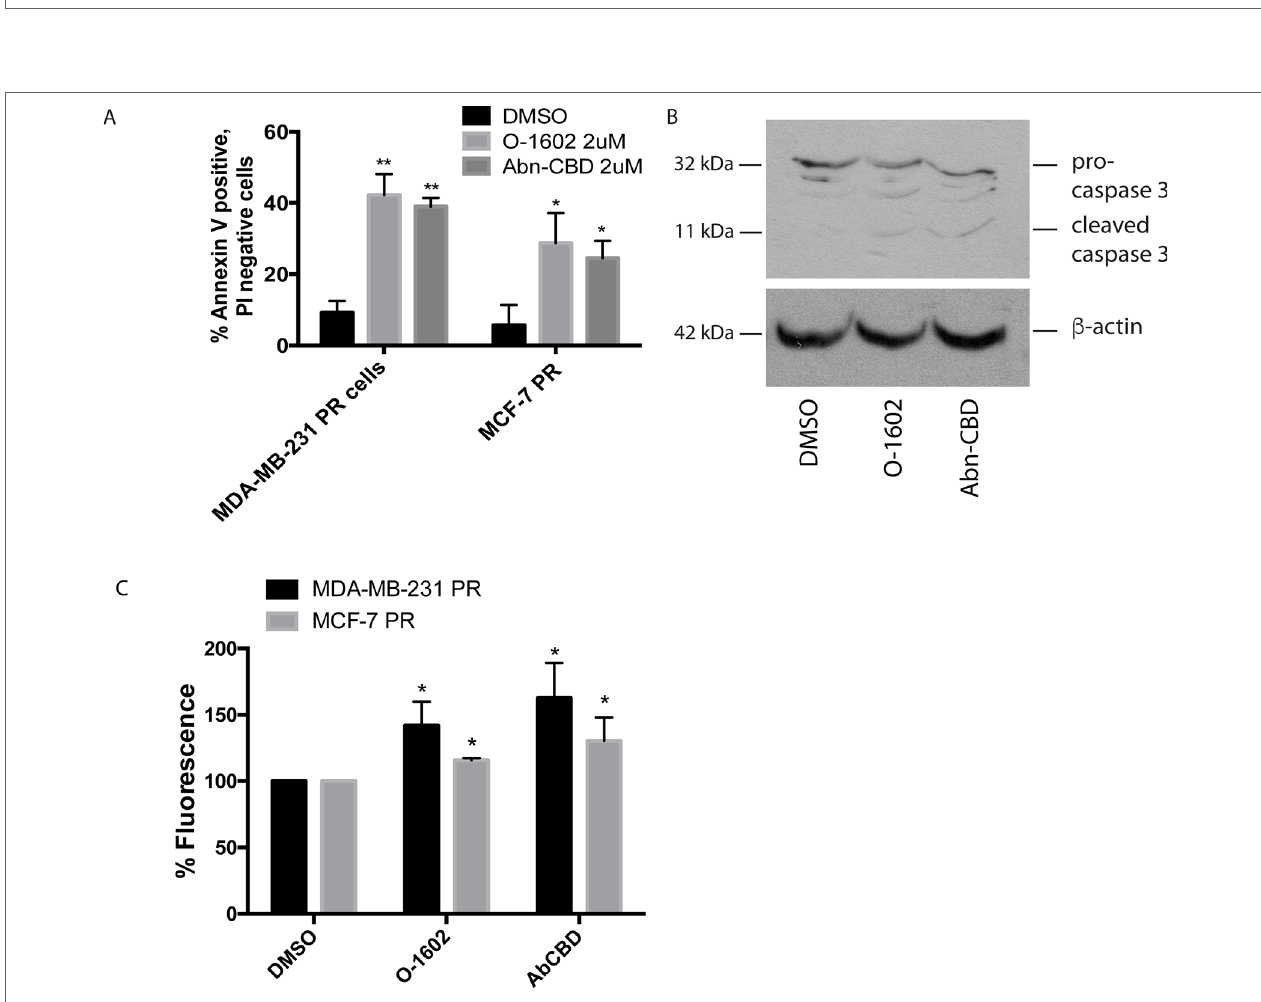
FIGURE 5 | Effect of atypical cannabinoids on apoptosis. Cells were treated for 24 h with either the DMSO vehicle, O-1602, or Abn-CBD. (A) Histogram showing the % of annexin V–labeled cells. Cells staining for PI only or both PI/AV are not shown. Cells were counted from three random fields of view on a fluorescence microscope. * p < 0.05, ** p < 0.01, n = 3. (B) Western blotting analysis was performed using an anti–caspase-3 antibody, and β -tubulin was included as a loading control. Figure is a representative blot of n = 3 experiments. (C) Reactive oxygen species assay measurements in MDA-MB-231 and MCF-7 cells following treatment with O-1602 or Abn-CBD. (n =